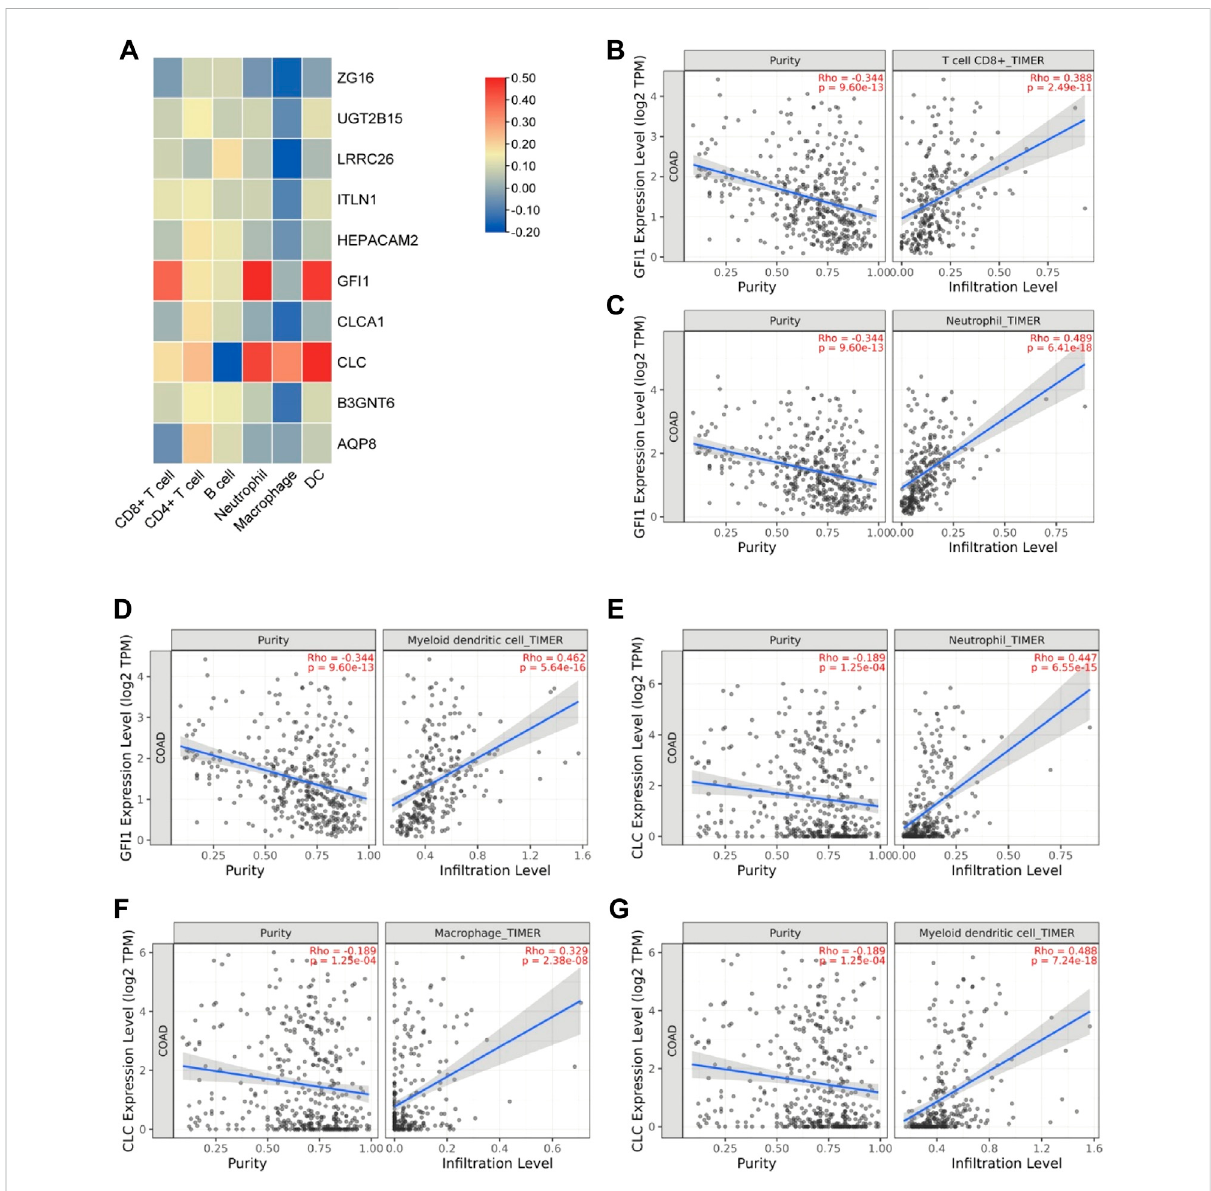
FIGURE 7 The relationshipbetweenDEGs and immune in fi ltrating cells. (A) Heatmap of thecorrelation between DEGs and immunecells. (B) Relationship betweenGFI1andCD8 + Tcells. (C) RelationshipbetweenGFI1andneutrophils. (D) RelationshipbetweenGFI1andDC. (E) RelationshipbetweenCLC and neutrophils. (F) Relationship between CLC and macrophages. (G) Relationship between CLC and